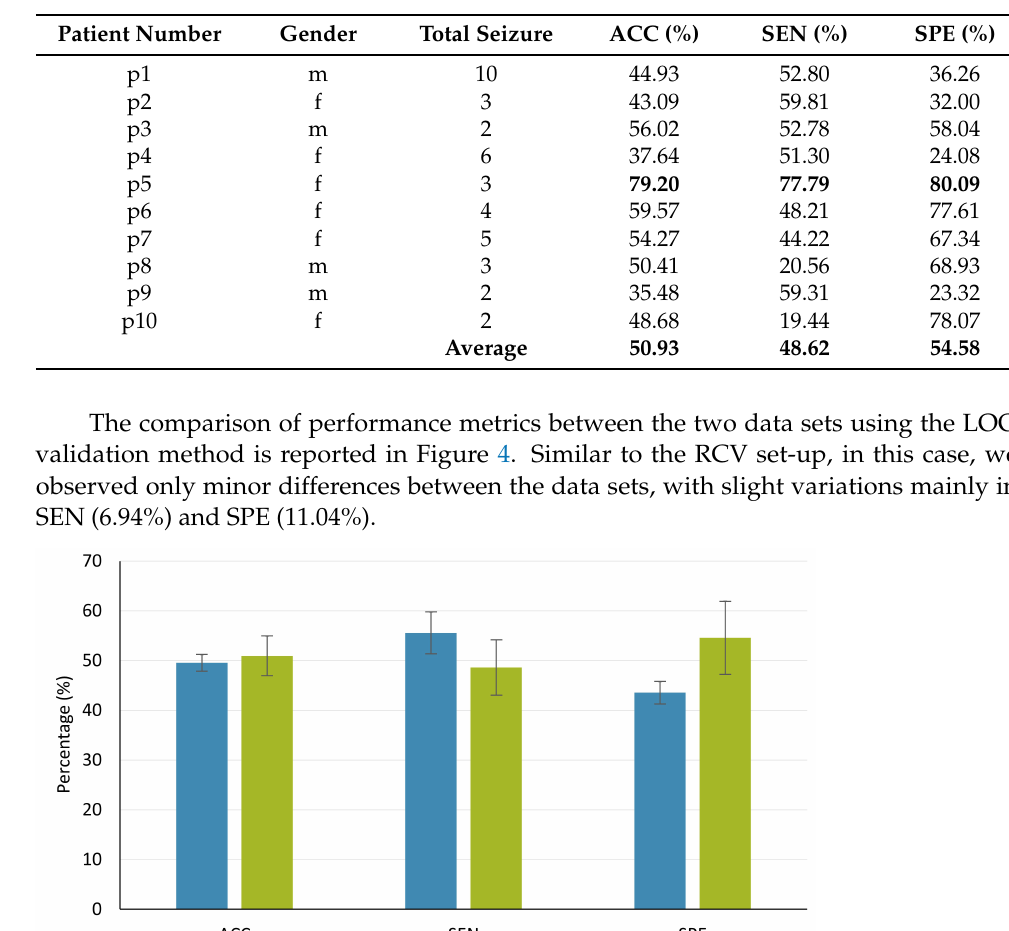
Table 4. LOO validation method’s results on our data set. Bold format highlights maximum values.